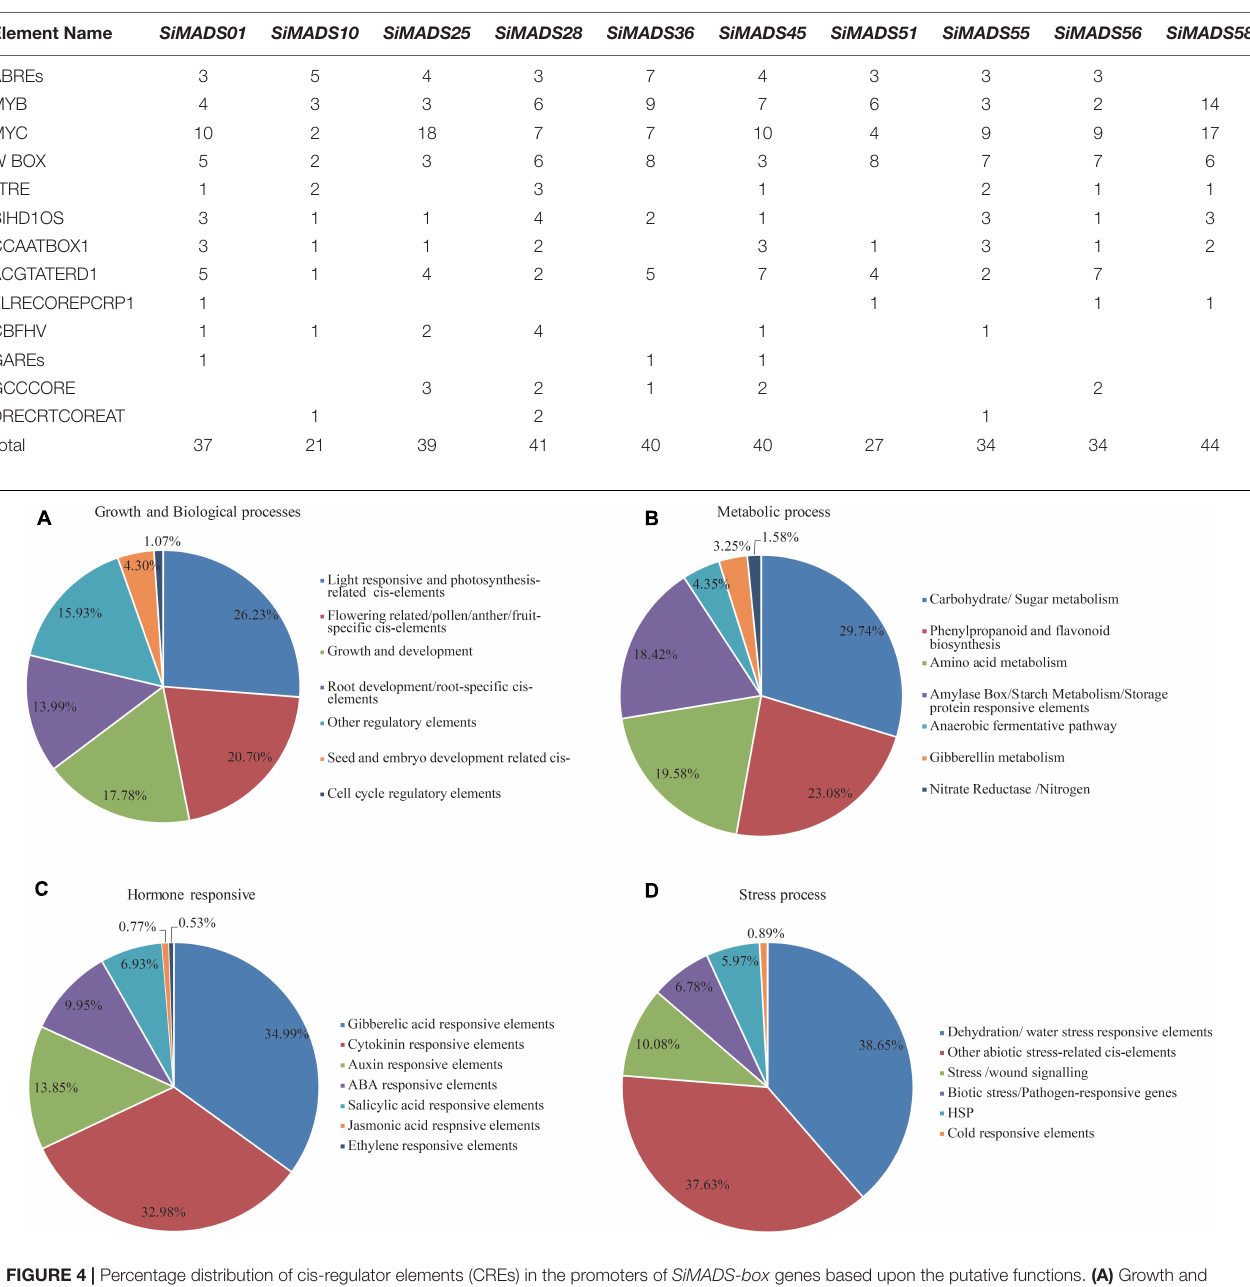
TABLE 3 | Number of cis -elements in the promoter region of 10 SiMADS-box genes.